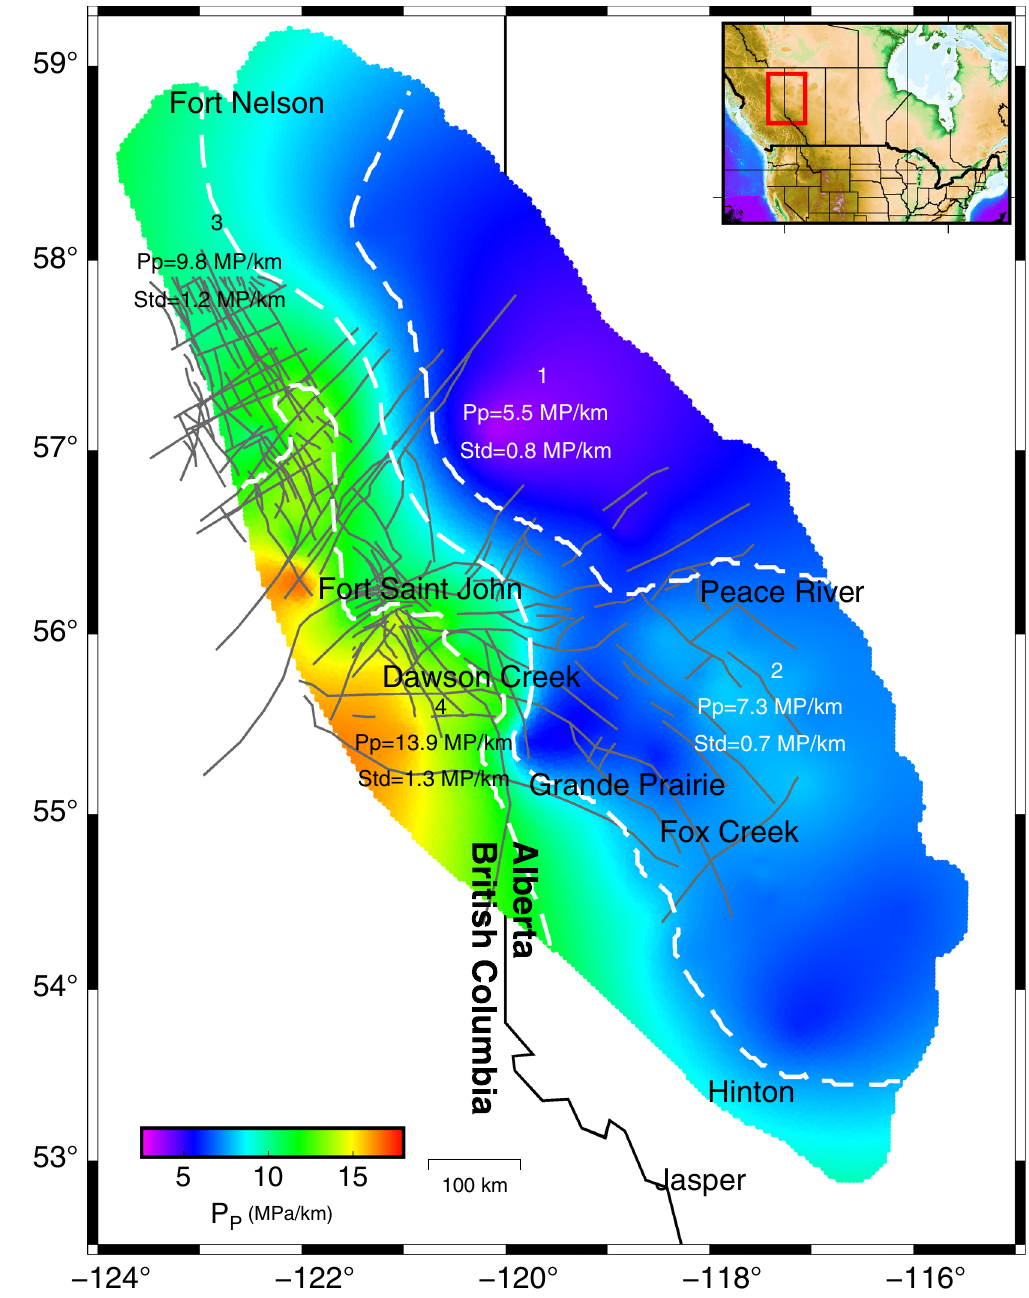
Figure 2. Spatial pore pressure gradient values in the Montney Formation. Extremely low Pp (5 MPa/km) are observed around Peace River and Grande Prairie where less seismicity has been recorded. Pore pressure gradients are highest (15 MPa/km) in the areas around Fort St. John and Dawson Creek. The western parts of the Formation have relatively higher pore pressure values and gradients than the eastern parts. Gray lines indicate faults crossing one another in the Montney play. The white dashes show the zoning of the Montney Formation based on pore pressure gradients at various locations. Each zone is represented by a mean pore pressure value (Pp) and a standard deviation (Std). The figure was generated using GMT V.6 37